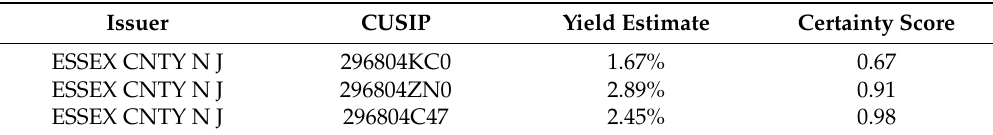
Table 2. Certainty scores of bond yield estimates.